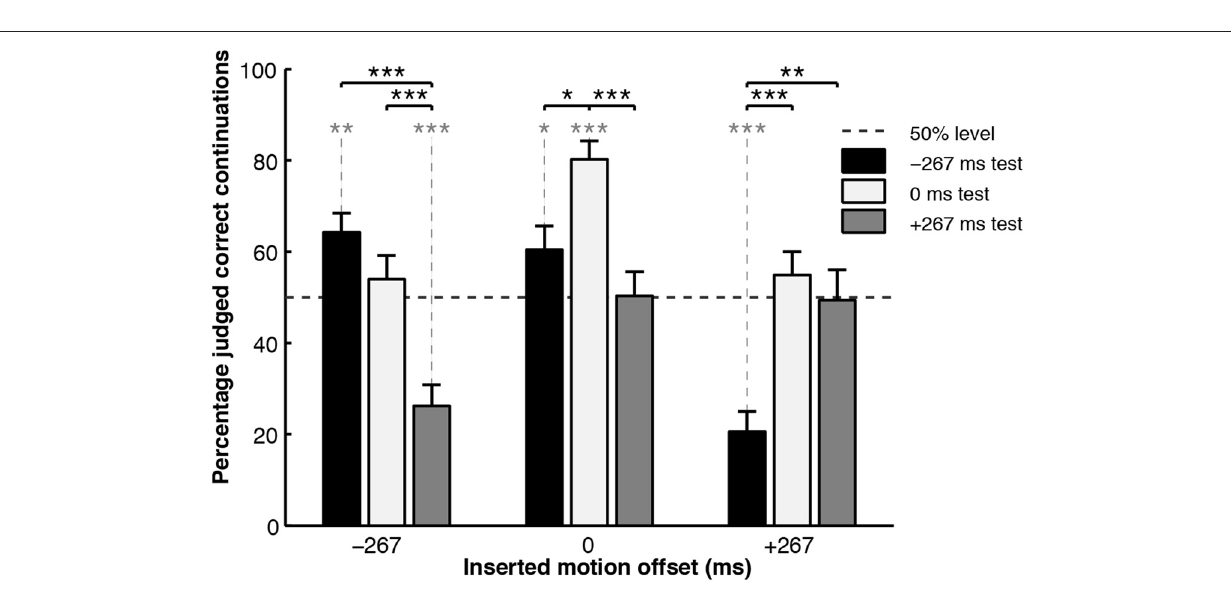
t -test comparisons to chance performance (50%), ∗ p < 0 . 05, ∗∗ p < 0 . 01, ∗∗∗ p < 0 . 001. Figure reproduced from Parkinson et al. (2012, p. 428). Copyright © Springer Science + Business Media. Reproduced with